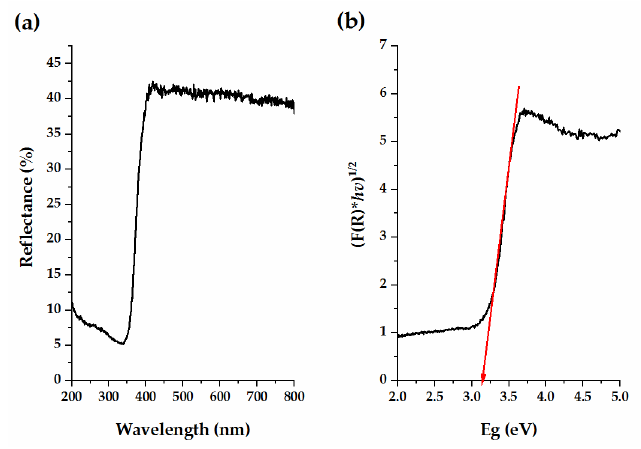
Figure 2. ( a ) Diffuse-reflectance spectrum (DRS) of N–TiO 2 sample; and ( b ) E g value determination.